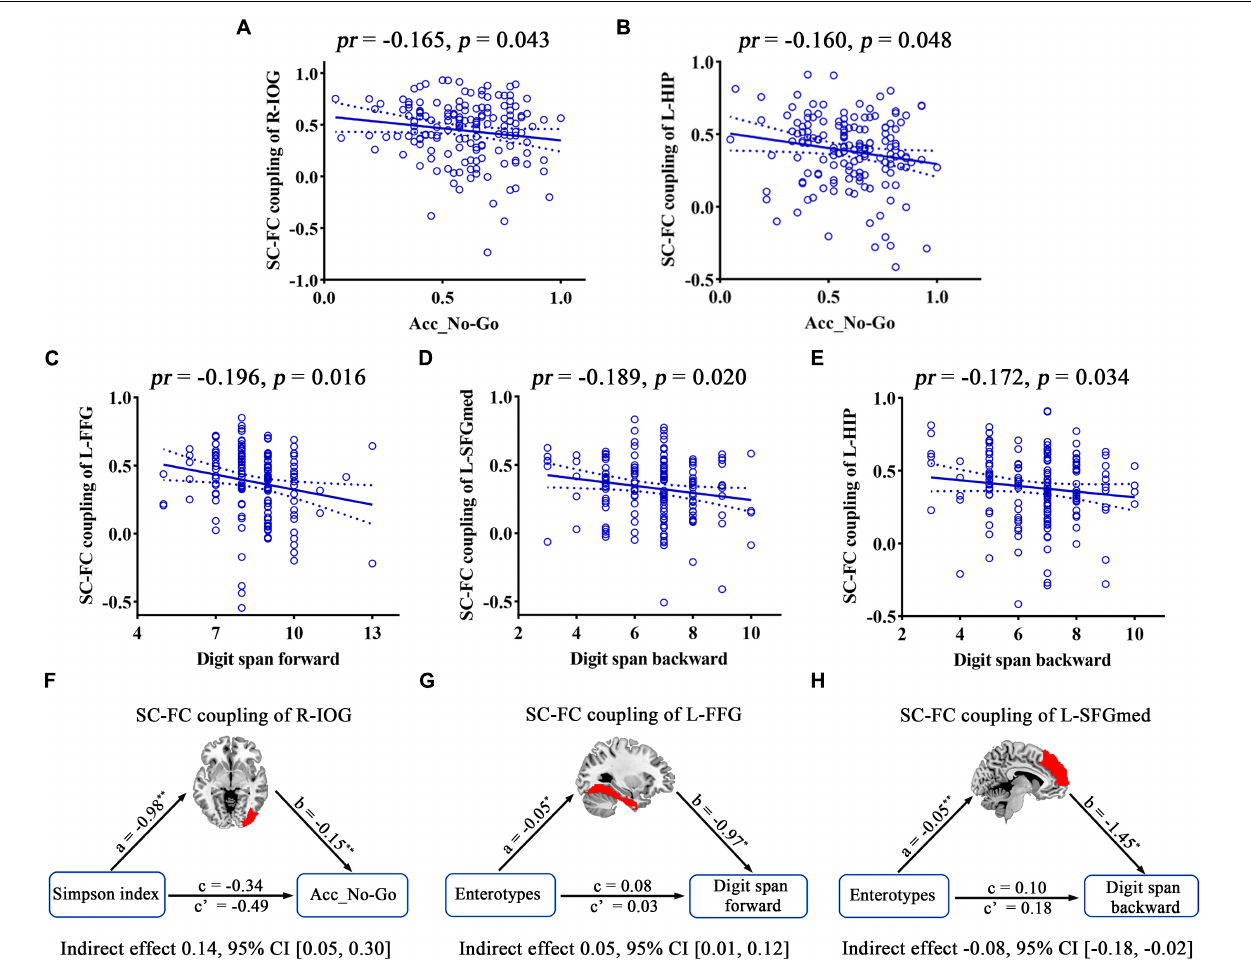
FIGURE 9 | Correlations and mediations between SC–FC coupling, gut microbiota, and cognition. (A–E) Scatter plots of the correlations between SC–FC coupling and cognition. (F–H) The mediation analyses between gut microbiota (X) and cognition (Y), with SC–FC coupling as the mediator (M). Path coefficients with p -values (* p < 0.05 and ** p < 0.01, respectively). Acc_No-Go, the accuracy in “No-Go” conditions; CI, confidence interval; FC, functional connectivity; FFG, fusiform gyrus; HIP, hippocampus; IOG, inferior occipital gyrus; L, left; pr , partial correlation coefficient; R, right; SC, structural connectivity; SFGmed, medial superior frontal